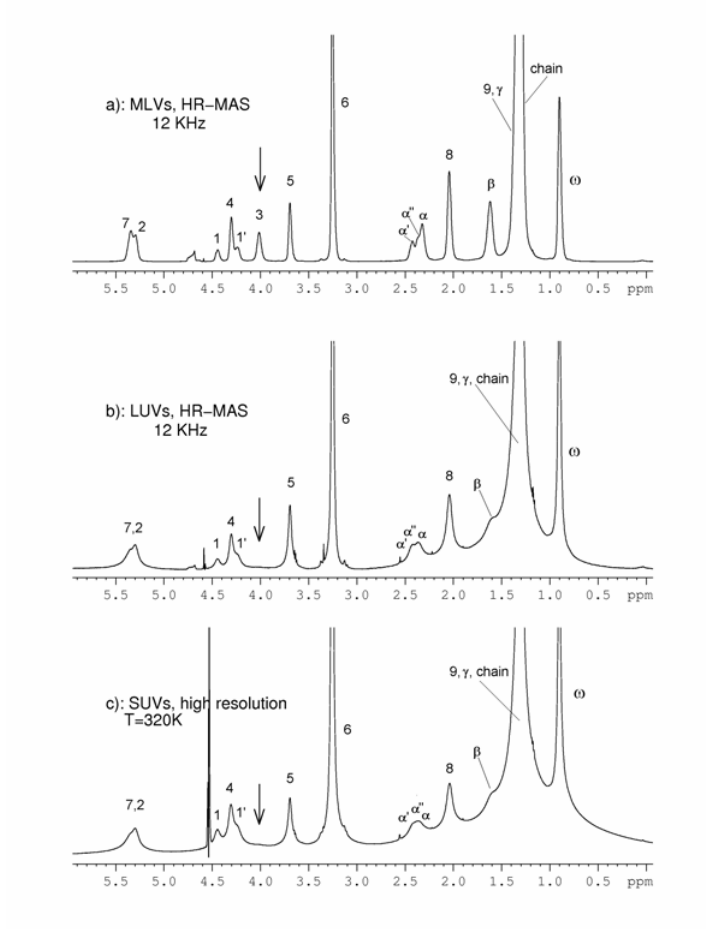
Figure 3 . 600 MHz 1 H-NMR spectra of different classes of POPC (50mg/mL) liposomes: a) HR-MAS spectrum of MLVs, 12kHz at 314.8 K; b) HR-MAS spectrum of LUVs, 12kHz at 314.8 K; c) 1H NMR spectrum of SUVs, no spinning at 320.0K. The arrows indicate the chemical shift position of CH 2